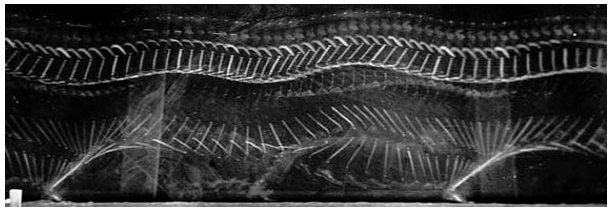
Figure 1. Cinematographic movement of marching soldier (image courtesy of Motion Studies predating Taylorism, Images produced by Etienne-Jules Marey ).